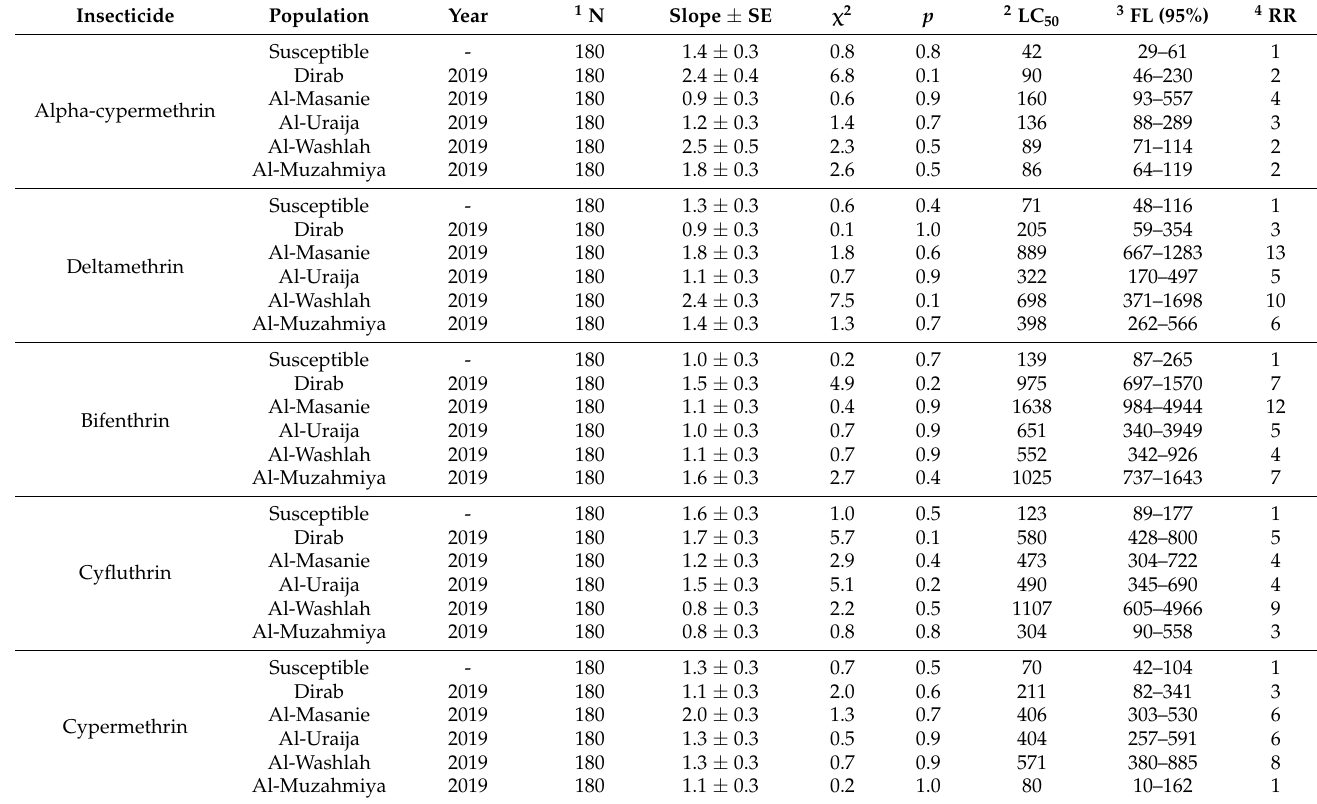
Table 1. Toxicity of pyrethroids in adult female house flies from different dairy farms.